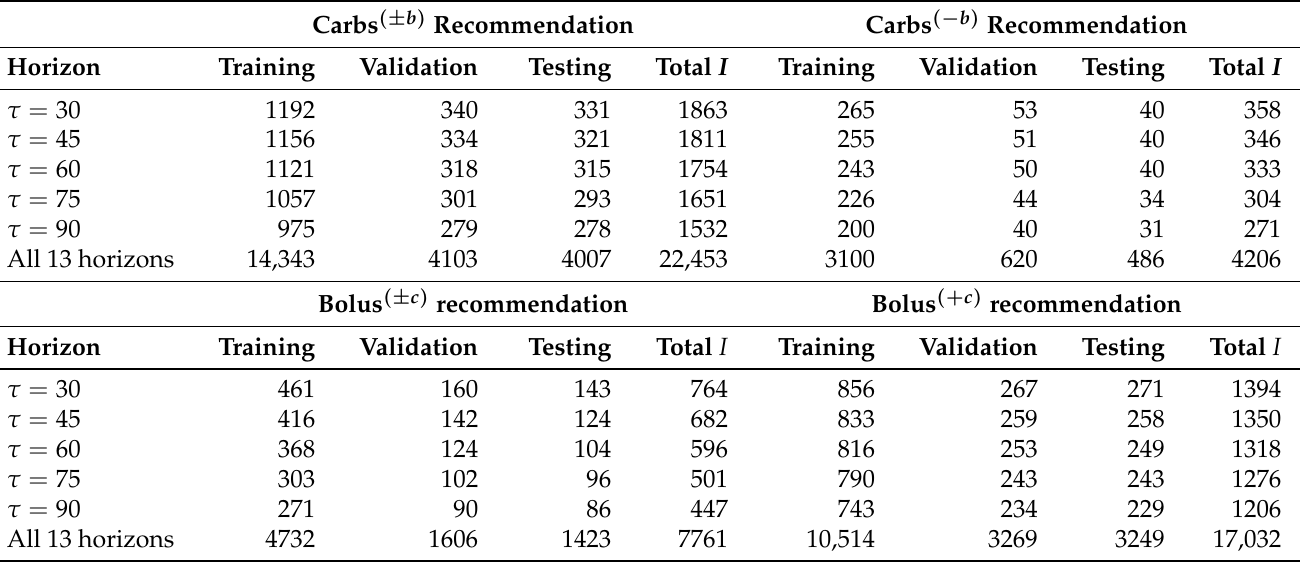
Table 3. Inertial ( I ) examples by recommendation scenario and prediction horizon. Carbs ( ± b ) refers to all carbohydrate intake events; Carbs ( − b ) refers to carbohydrate intakes without a bolus.